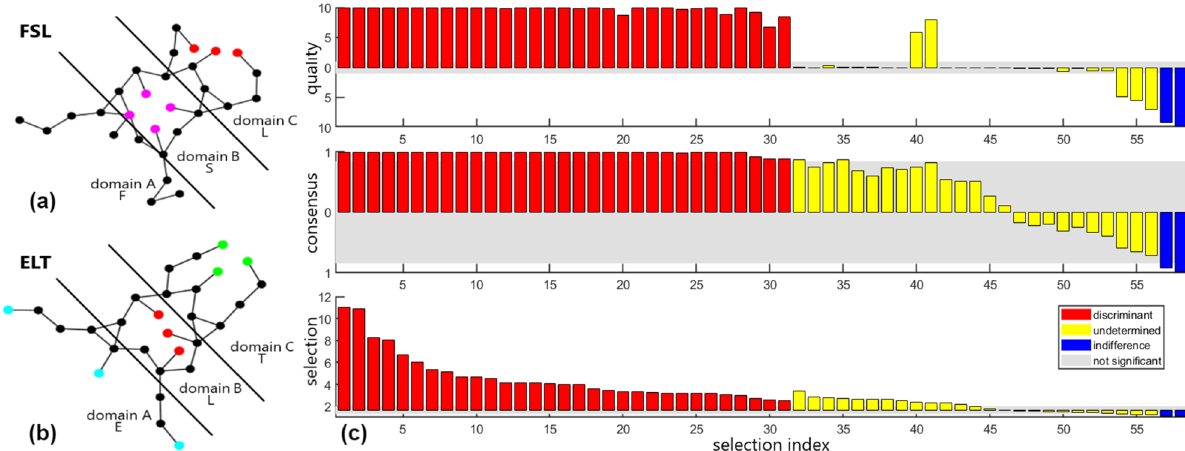
Figure 4. Discriminant analysis on synthetic molecules. (a) The synthetic molecule FSL indicates Free-Square- Linear geometric signatures are present within domains A, B, and C respectively. Free indicates no restraining forces are applied in that region. (b) The synthetic molecule ELT indicates Extended-Linear-Triangular geometrical signatures within domains A, B, and C respectively. The extended structure emulates a pose for binding to a receptor. (c) The vector space is partitioned into (discriminant, undetermined, indifferent) subspaces, spanned by (d-modes, u-modes, i-modes) shown in bar-graphs, colored as (red, yellow, blue). The decision triad criteria are shown as stacked bar graphs with selection (bottom) corresponding to the signal- to-noise scoring function that rank-orders the modes within each subspace separately, consensus (middle) and quality (top). Consensus and quality values are plotted (above, below) the 0-reference line when selection is (above, below) the bifurcation reference. Gray background shows the decision triad acceptance thresholds. As an output from SPLOC-RNN, the stacked bar graph format highlights the characteristic strengths and weaknesses of each